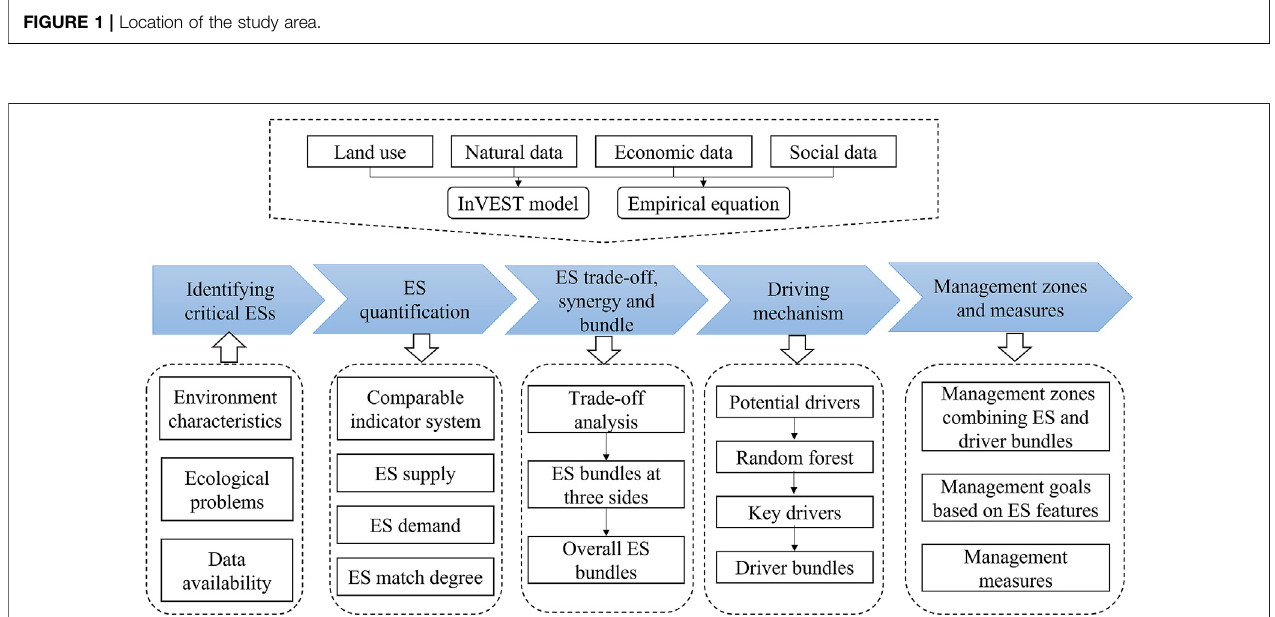
FIGURE 2 | Framework for dividing management zones and proposing measures based on ES supply – demand, tradeoffs, and environmental characteristics.